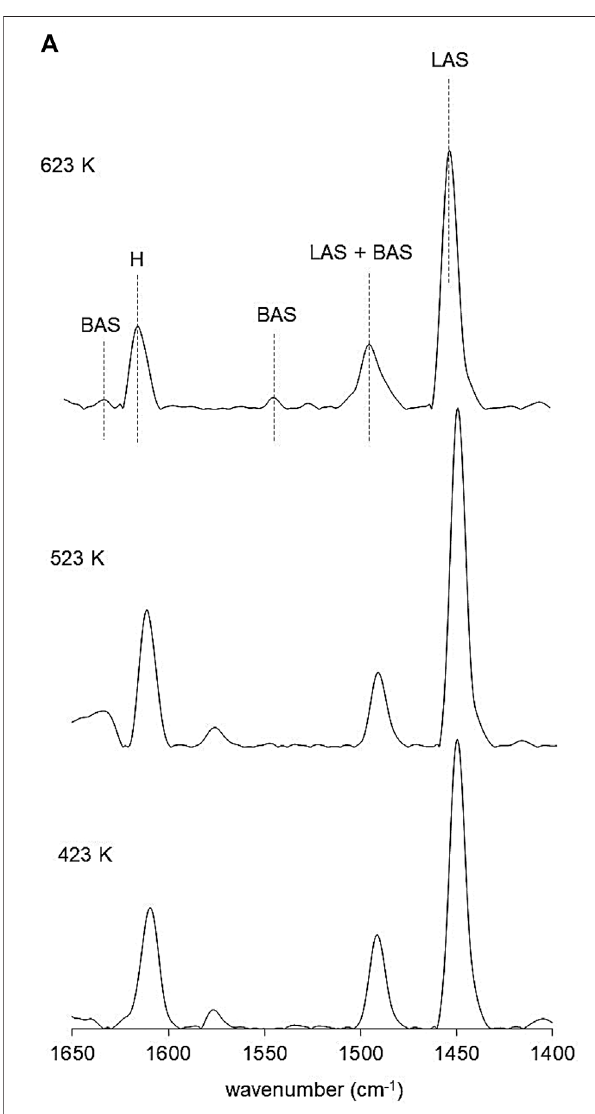
FIGURE 5 | (A) FTIR spectra of pyridine adsorption over the NiP-S/ γ - Al 2 O 3 -MgO catalyst. (B) FTIR spectra of pyridine adsorption over the NiMoP- S/ γ -Al 2 O 3 -MgO catalyst.